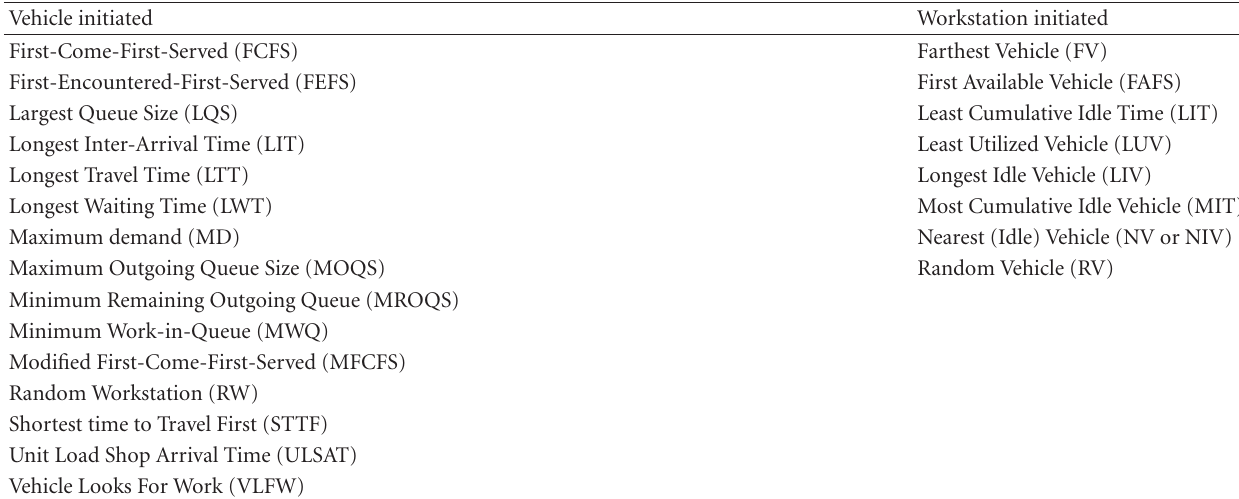
Table 1: Summary of AGV dispatching